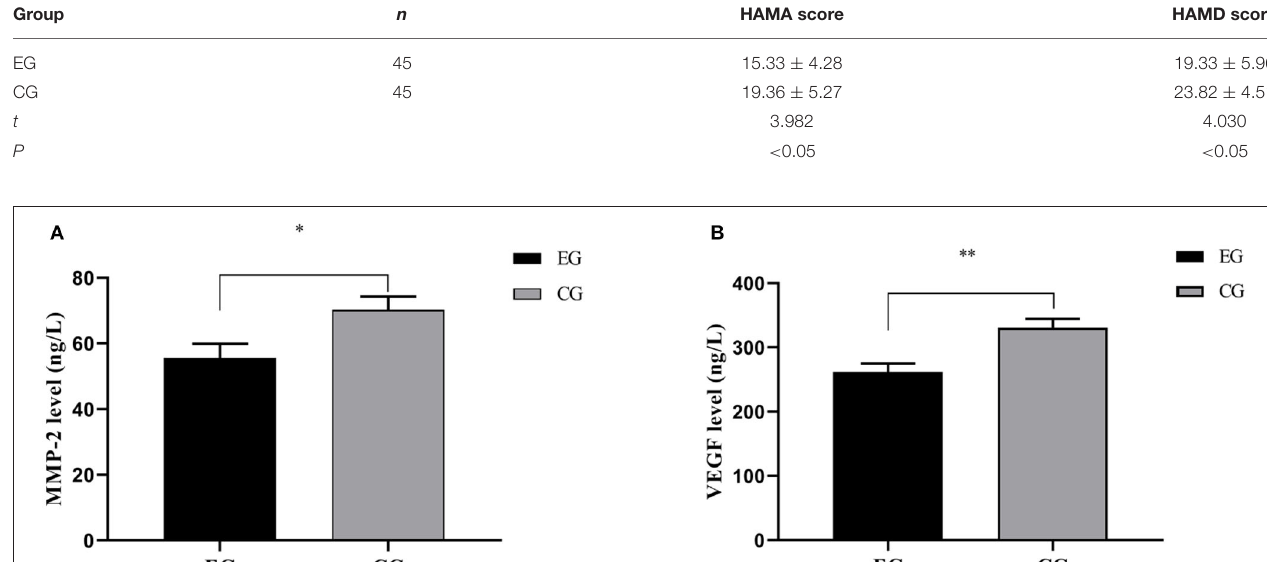
TABLE 3 | Comparison of negative emotion scores [Mean ± SD].